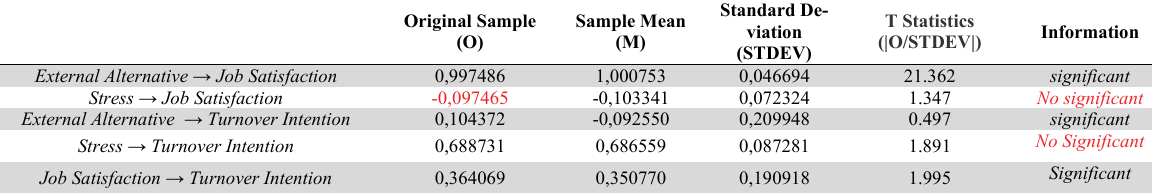
Path Coefficients (Mean, STDEV,